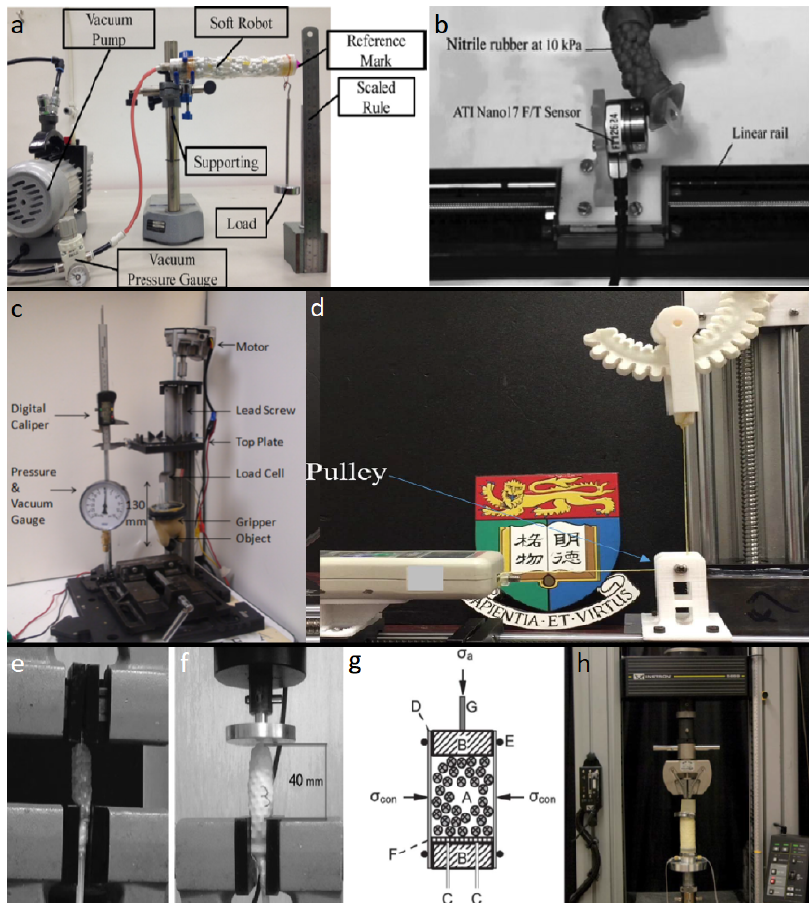
Figure 4. A selection of photos of various laboratory controlled experiments performed to ascertain jamming actuator performance. Note a lack of standardisation in testing—cantilever-beam tests are conducted with differing orientations, for example. From left to right, top to bottom, ( a , b ) shows two cantilever beam tests to assess stiffness through load vs. displacement via measuring the force required to displace